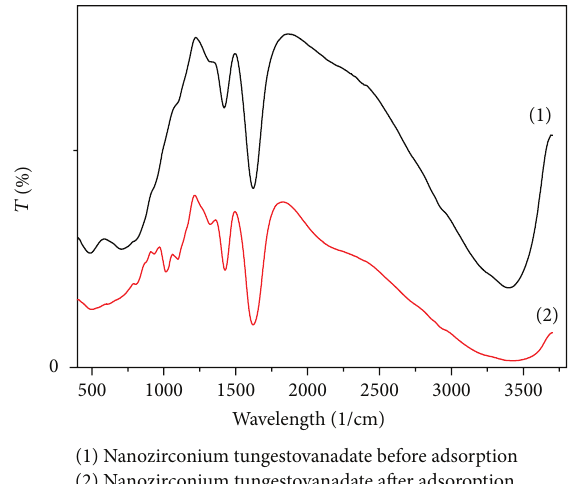
Figure 8: FTIR spectrum of (1) free zirconium tungestovanadate- alginate hybrid matrix and (2) zirconium tungestovanadate-alginate hybrid matrix after dye sorption process.